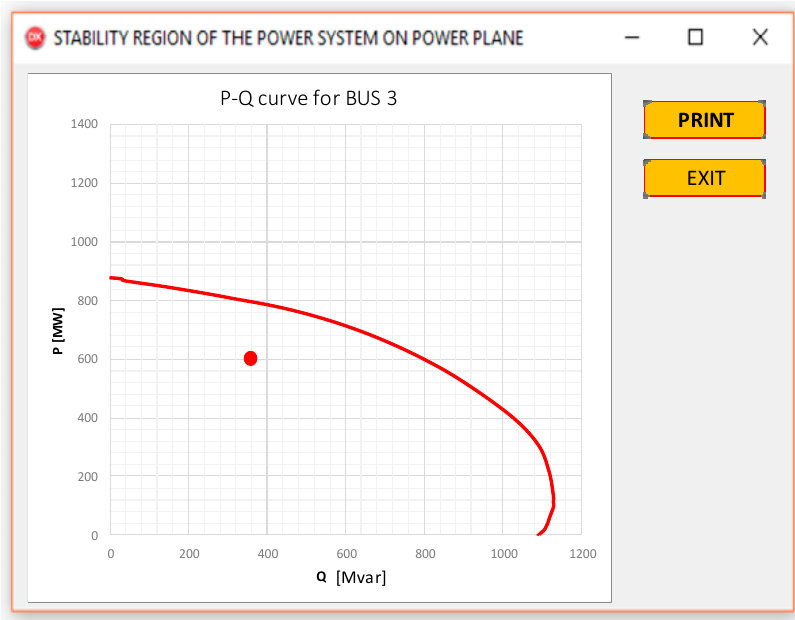
Figure 11. Operating region at Bus 3.